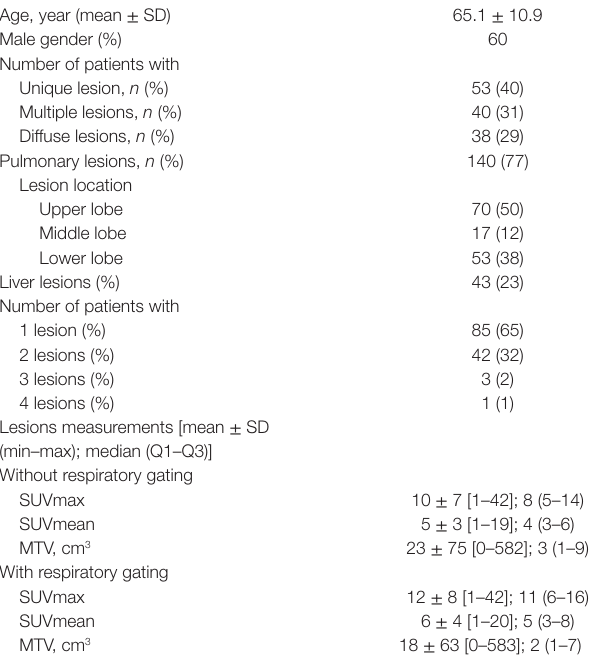
Table 1 | Patients characteristics, tumor characteristics, number of lesions per patient, and lesion location and lesions measurements [SUVmax, SUVmean, metabolic tumor volume (MTV)] with and without respiratory